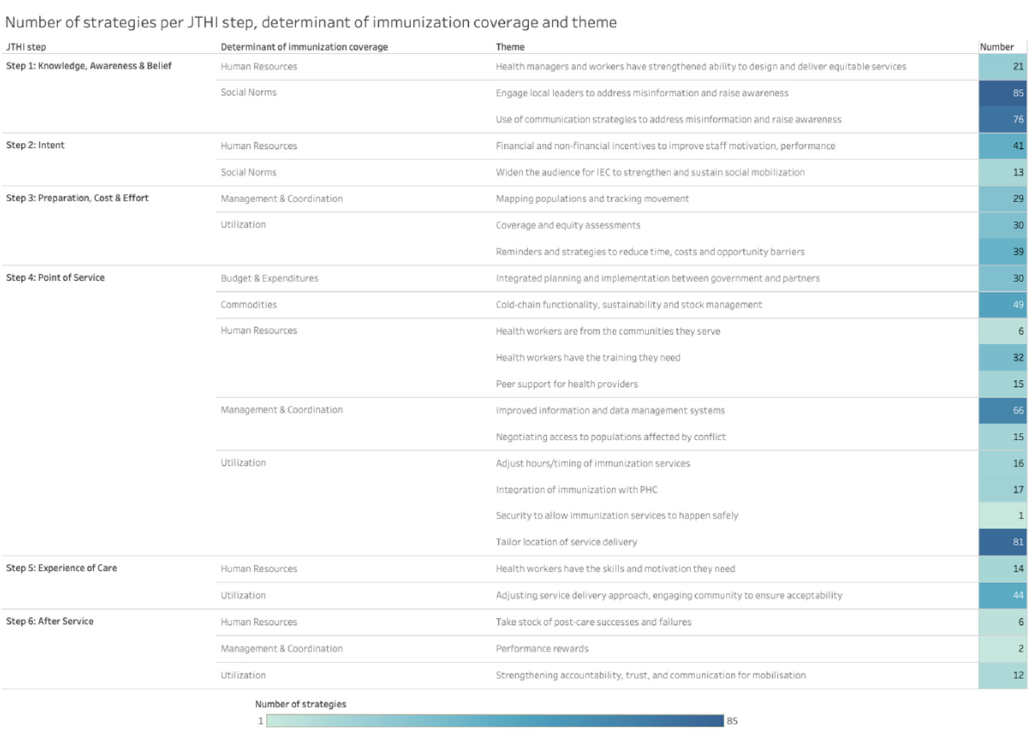
Figure 3. Number of strategies per JTHI step, determinant of immunization coverage and theme. Pro-equity strategies relevant to JTHI step 4 (Point of Service) targeted a variety of determinants and themes, including Utilization ( n = 115 [16%]), Management and Coordination ( n = 81 [11%]), Human Resources ( n = 53 [7%]), Commodities ( n = 49